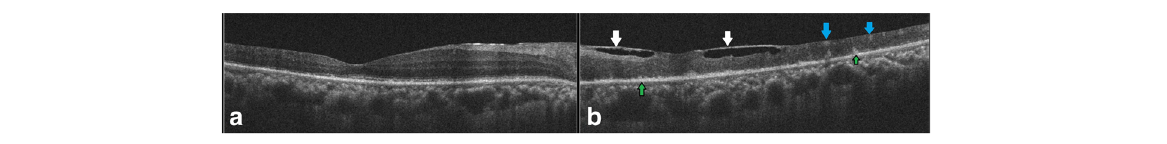
Fig. 5 Optical coherence tomography of a the right eye showing a normal foveal contour and b the left eye showing epiretinal membrane (white arrow) with superficial retinal precipitates (blue arrow) and irregularity of the retinal pigment epithelium (green arrow with black